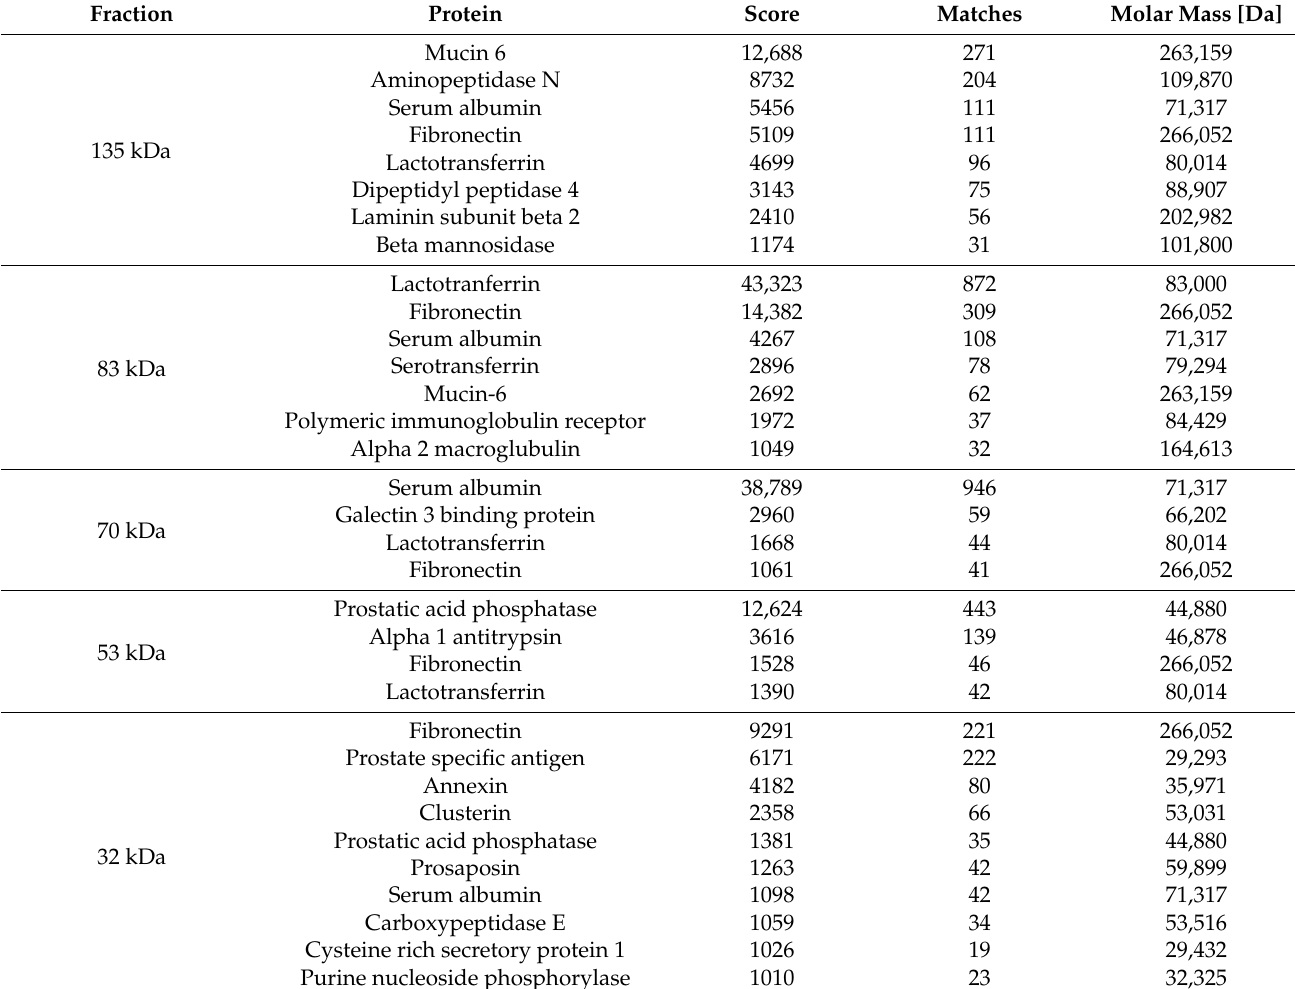
Table 1. LC-MS protein identification of lectin-reactive bands separated by